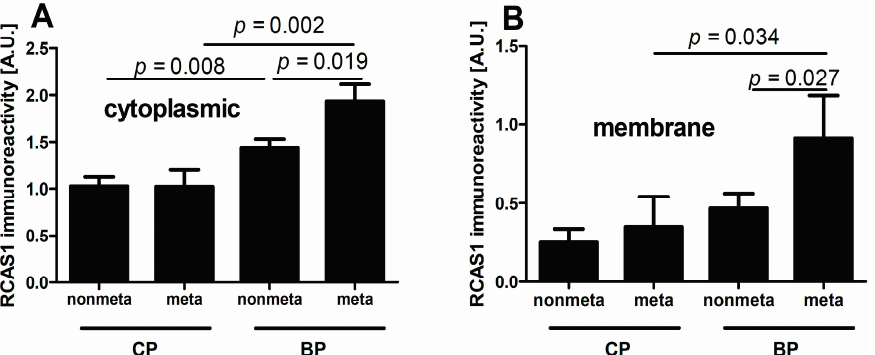
Figure 4. Relationship between cytoplasmic ( A ) and membrane ( B ) RCAS1 immunoreactivity of nonmetastasizing (nonmeta) and metastasizing (meta) bladder